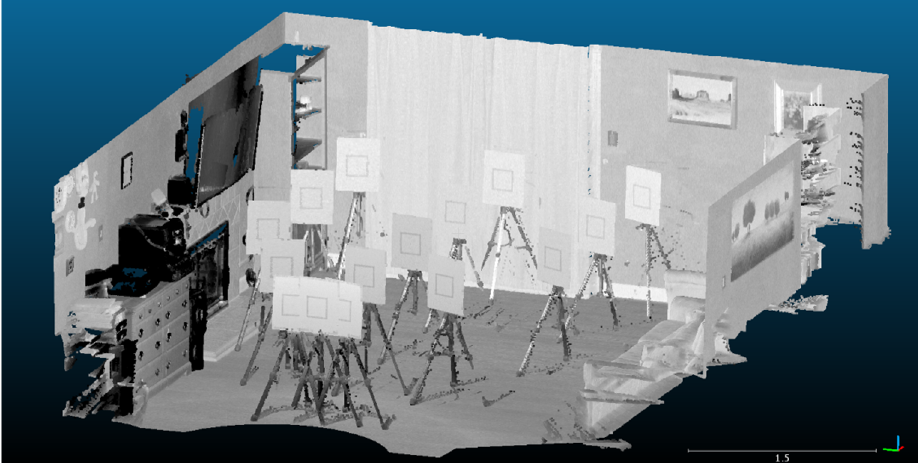
Figure 7. All fifteen FARO scans are registered relative to one another in the static scene.